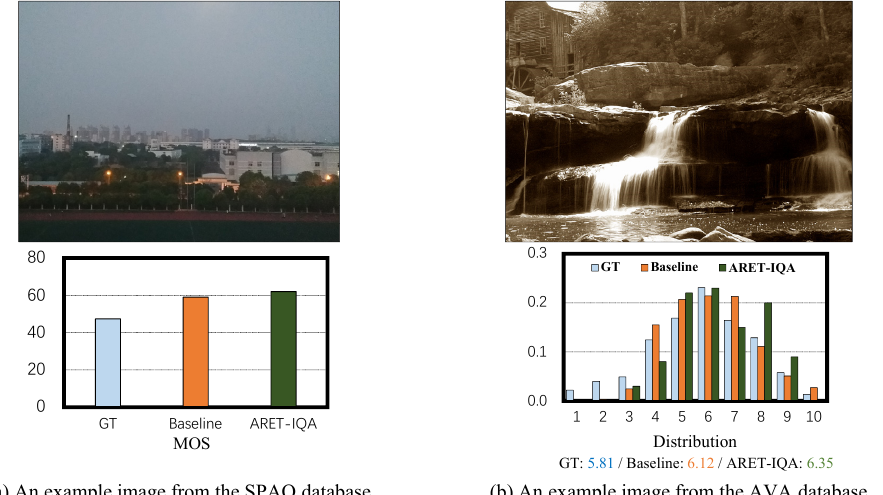
Figure 5. Two failure examples of the proposed ARET-IQA (384) and the baseline model on the SPAQ [27] and AVA [11] databases. The predicted quality scores (MOS or distribution) of the baseline and our ARET-IQA as well as the corresponding ground truth (GT) are shown below each image. In the AVA database, we also show the average scores of aesthetic